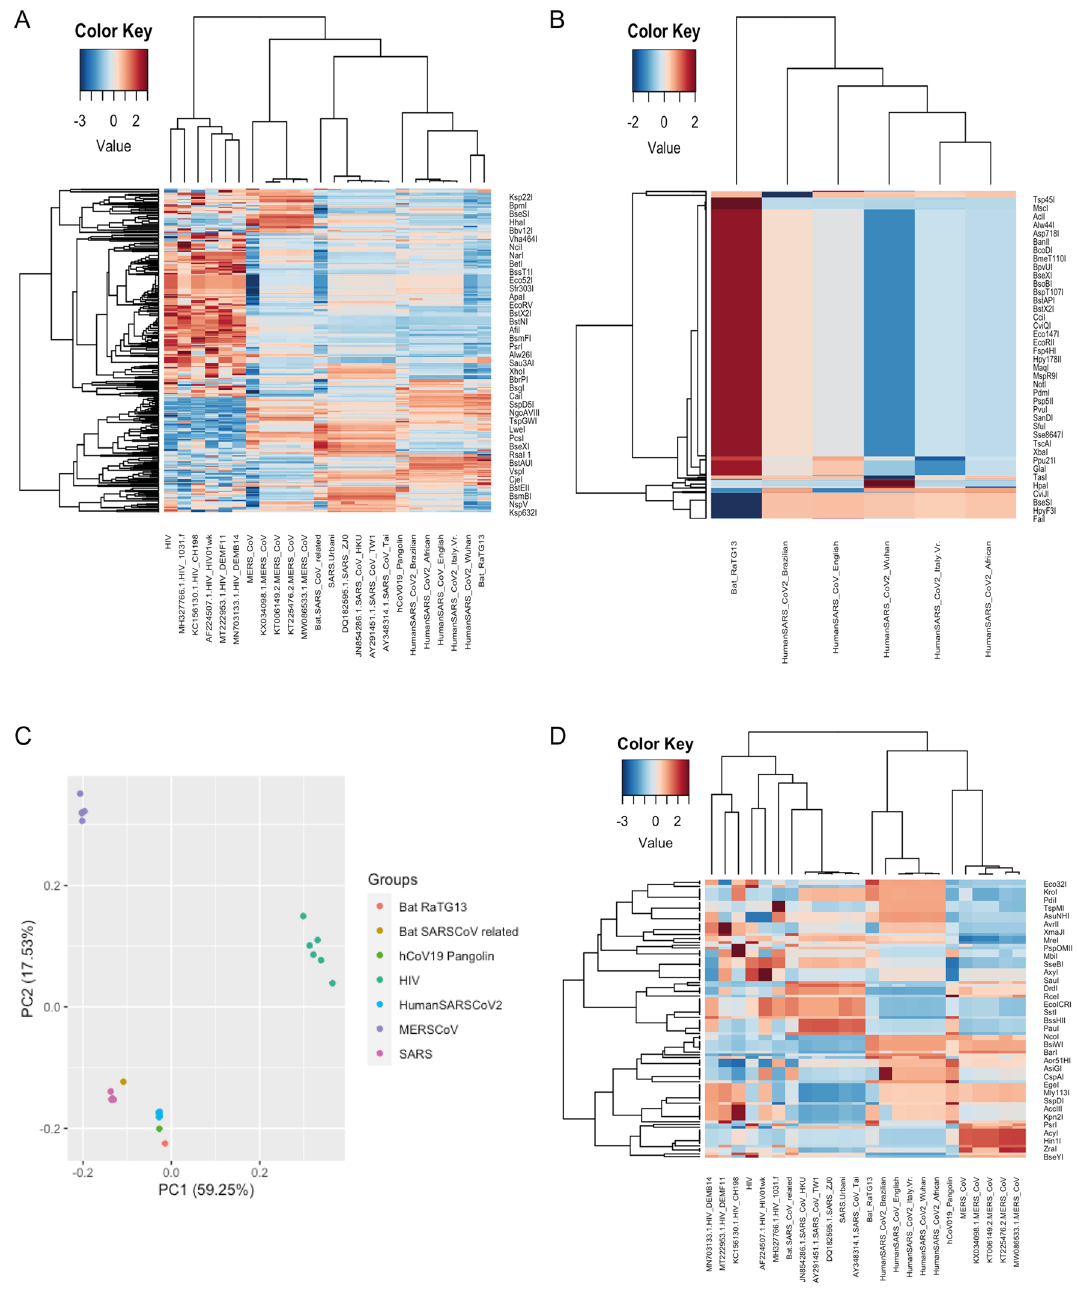
Figure 2. RS barcodes map help to determine the distance between different viruses’ genomes. ( A ) RSs barcode map of 7 different virus genomes. The colour scale represents the frequency to find that specific RS in the genome after using the Serial Cloner Library using 741 RSs. The hierarchical clustering was performed using Pearson correlation as distance metric. It is clear that some barcode patterns highlight similarities between related viruses, while other patterns show dissimilarities, such as the case of the HIV, used as control, which shows a clear different barcode compared with SARS-CoV-2 genomes. B) RSs barcode map performed on a region of 300 bp previously identified from the full map. Here, we compared the two human SARS-CoV-2 (Wuhan and Italian-VR) with most closed genome of the Bat-RaTG13. The barcode generated easily highlights similarities or differences between genomes presenting high genetic similarities. ( C ) Principal component analysis (PCA) plot generated with the frequencies of the RSs, retrieved from each of these genomes, confirms same distance between viruses’ genomes. ( D ) Barcode Heatmap with hierarchical clustering based on the most informative RSs showing that Human SARS-CoV-2 and Bat-Cov-RaTG13 are evolutionarily closer than hCoV- 19 Pangolin and MERS CoV. The clustering performed with less RSs confirms that we are still able to generate the right distance